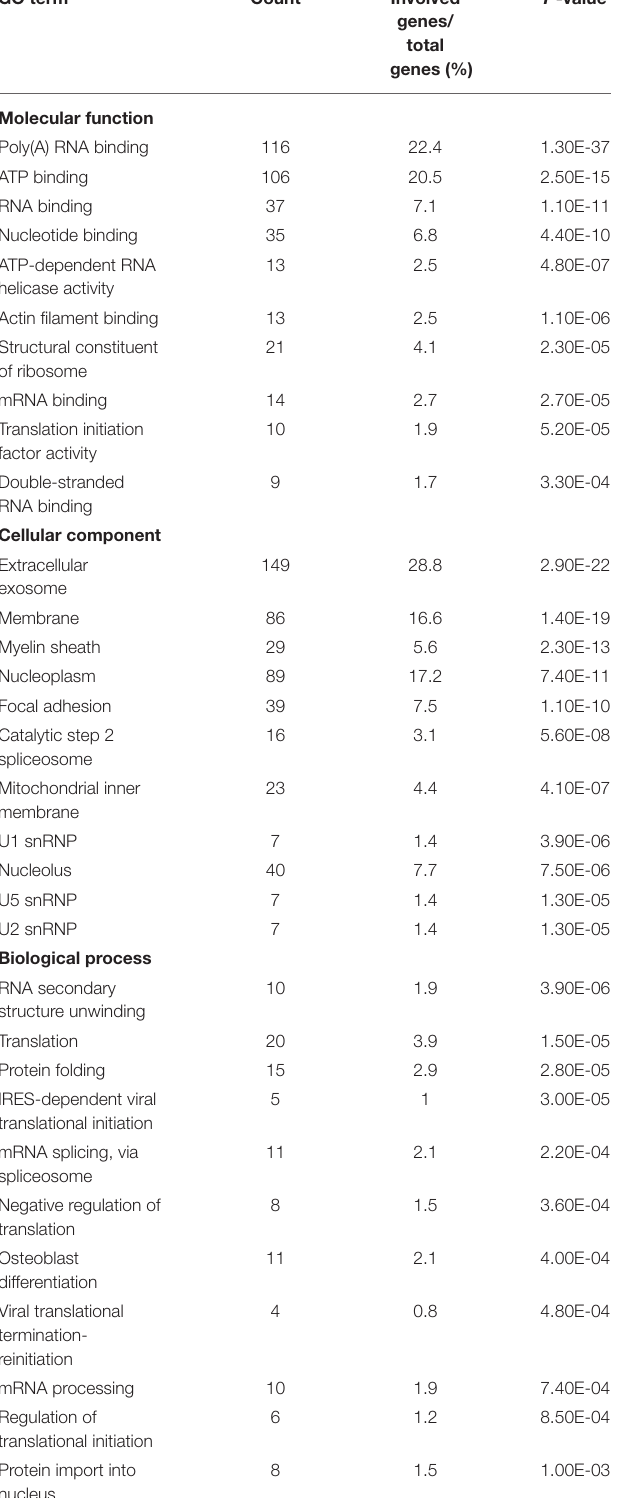
TABLE 1 | Gene Ontology terms enriched among host proteins interacting with H5N1 AIV. GO term Count Involved